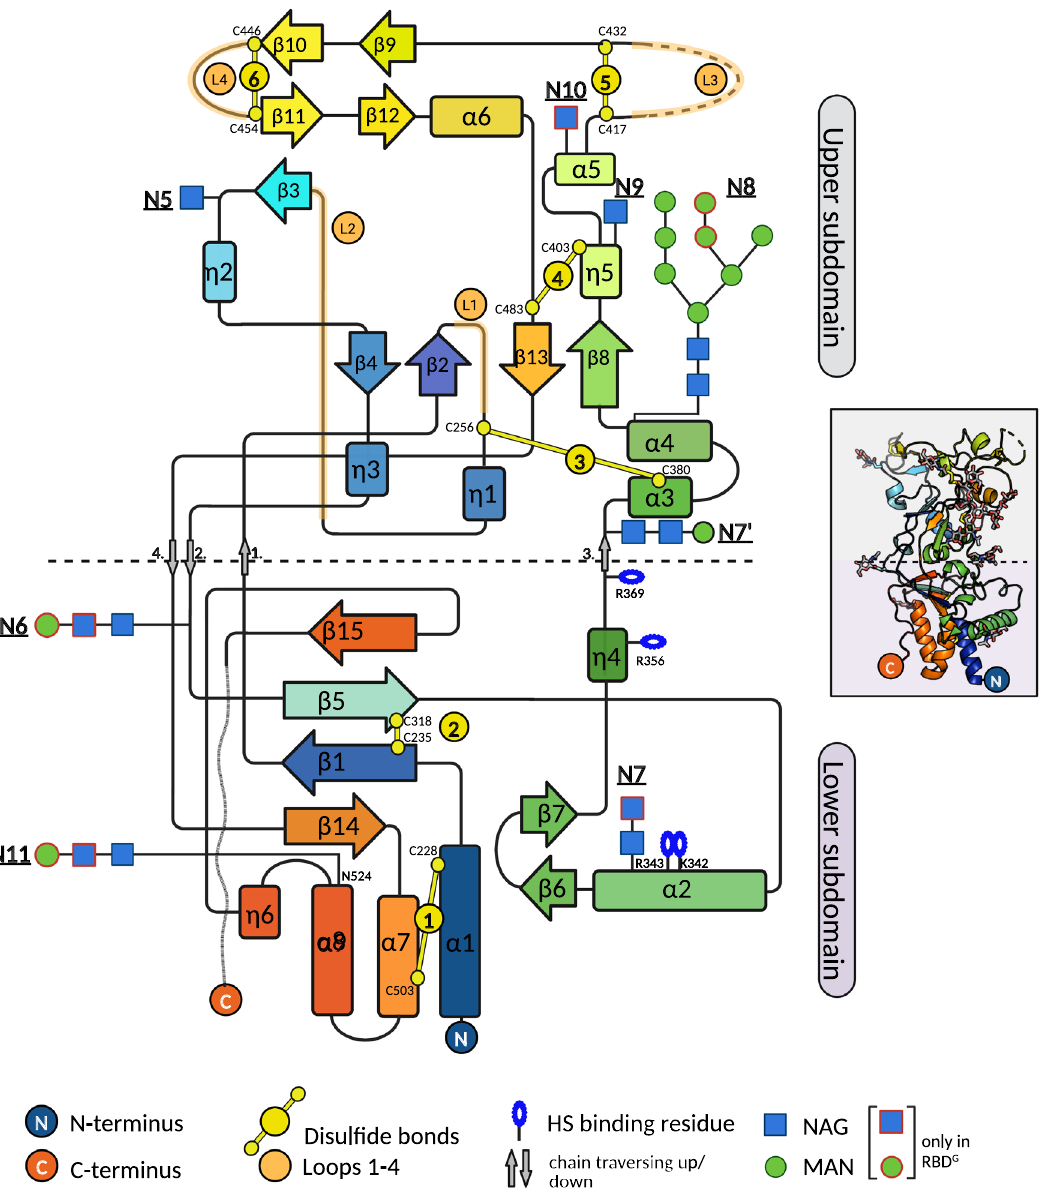
Fig. 2 | SFVRBD secondary structure topology diagram. The horizontaldashed-line designatesthe boundarybetweenthe lowerand uppersubdomains. The NAGand MAN units built only into the RBD G (and not RBD D ) structure are indicated with red frames. The fi gure was created with